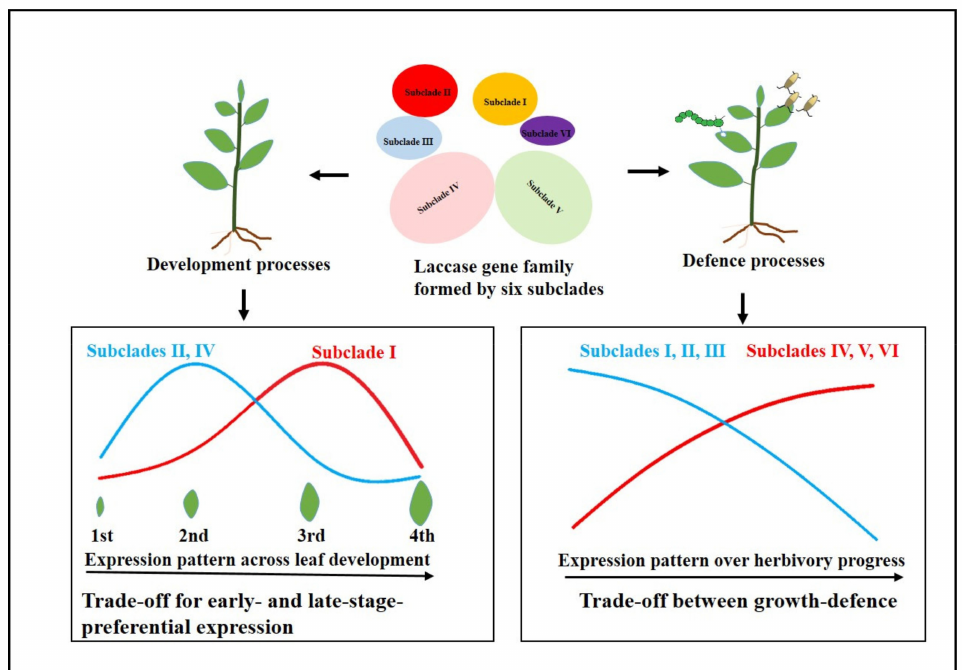
Figure 9. Schematic diagram showing LAC gene family-mediated trade-offs during tea plant develop- ment and defense processes. The curve (red) indicates transcripts that increase with leaf development or damages under herbivore attack. The curve (blue) represents transcripts that decrease with the progress of leaf development or